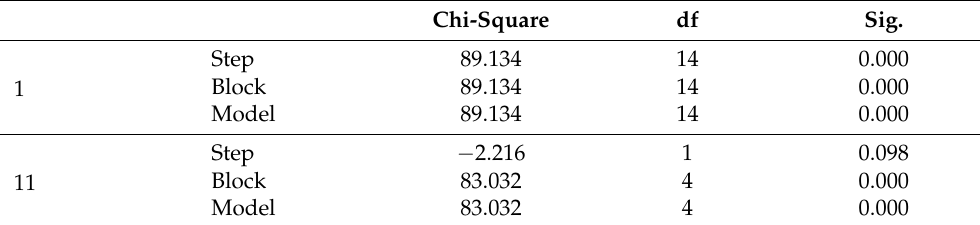
Table 5. Omnibus Tests of Model Coefficients.